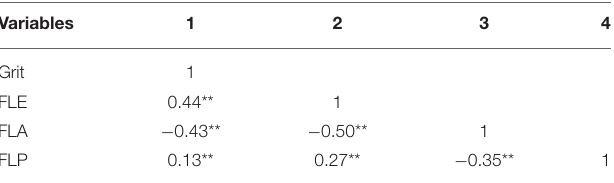
TABLE 4 | Pearson’s correlation analysis among key variables.